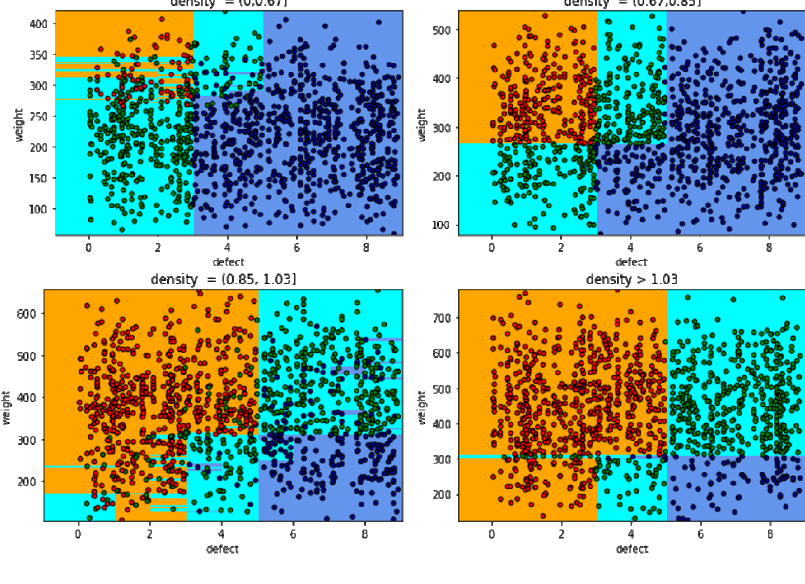
Figure 23. Classification of RF model. Appl. Sci. 2020 , 10 , x FOR PEER REVIEW